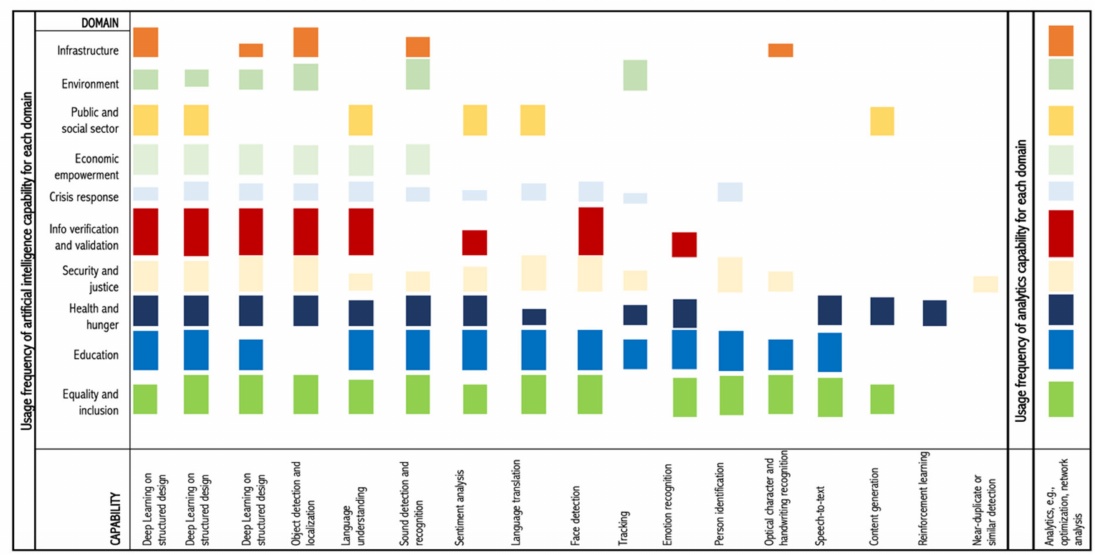
Figure5. AIcapabilitiesandtheirusebydomains, derivedfromMcKinseyGlobalResearchInstitute[93].